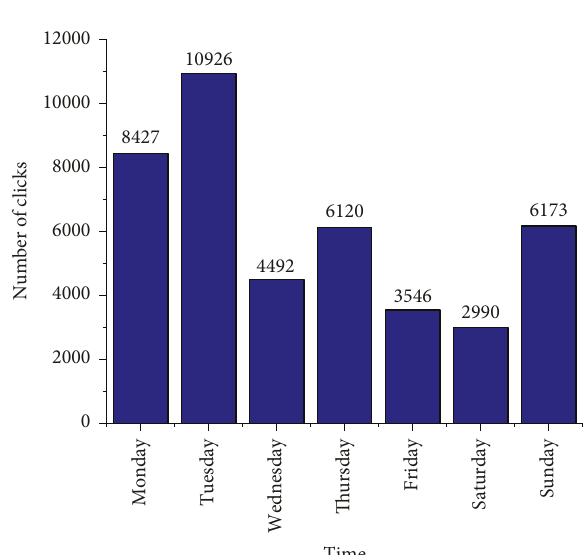
Figure 2: The number of clicks made by students per